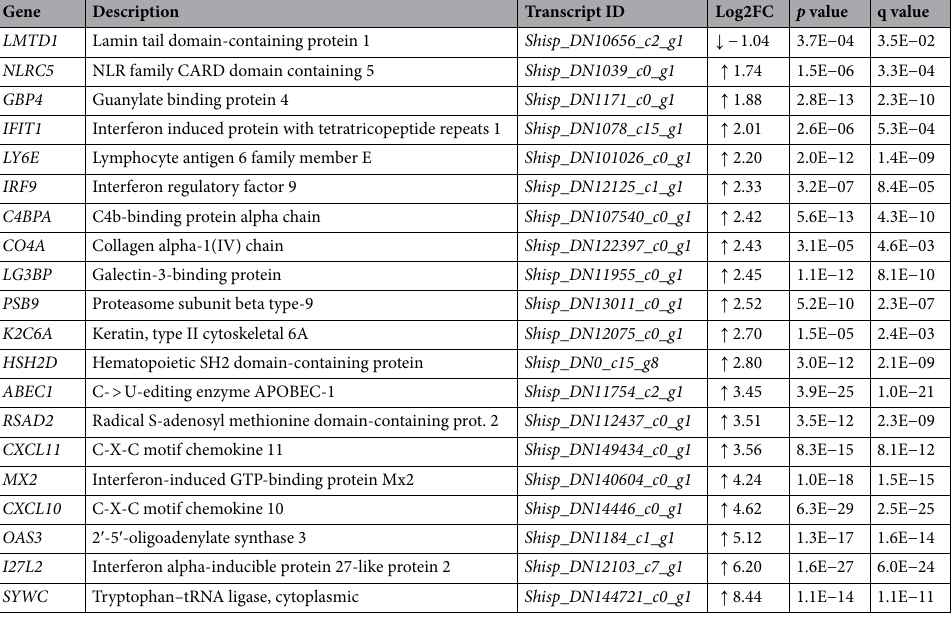
Table 3. Twenty notable differentially expressed genes in S. hispidus lung following RSV infection. Negative Log2FC = downregulated, positive Log2FC = upregulated. Gene names/descriptions determined by BlastX against UniRef/SwissProt. Transcript IDs correspond to contig names (Shisp_xxx) in assembly FASTA file. Log2FC = log2FoldChange, q =